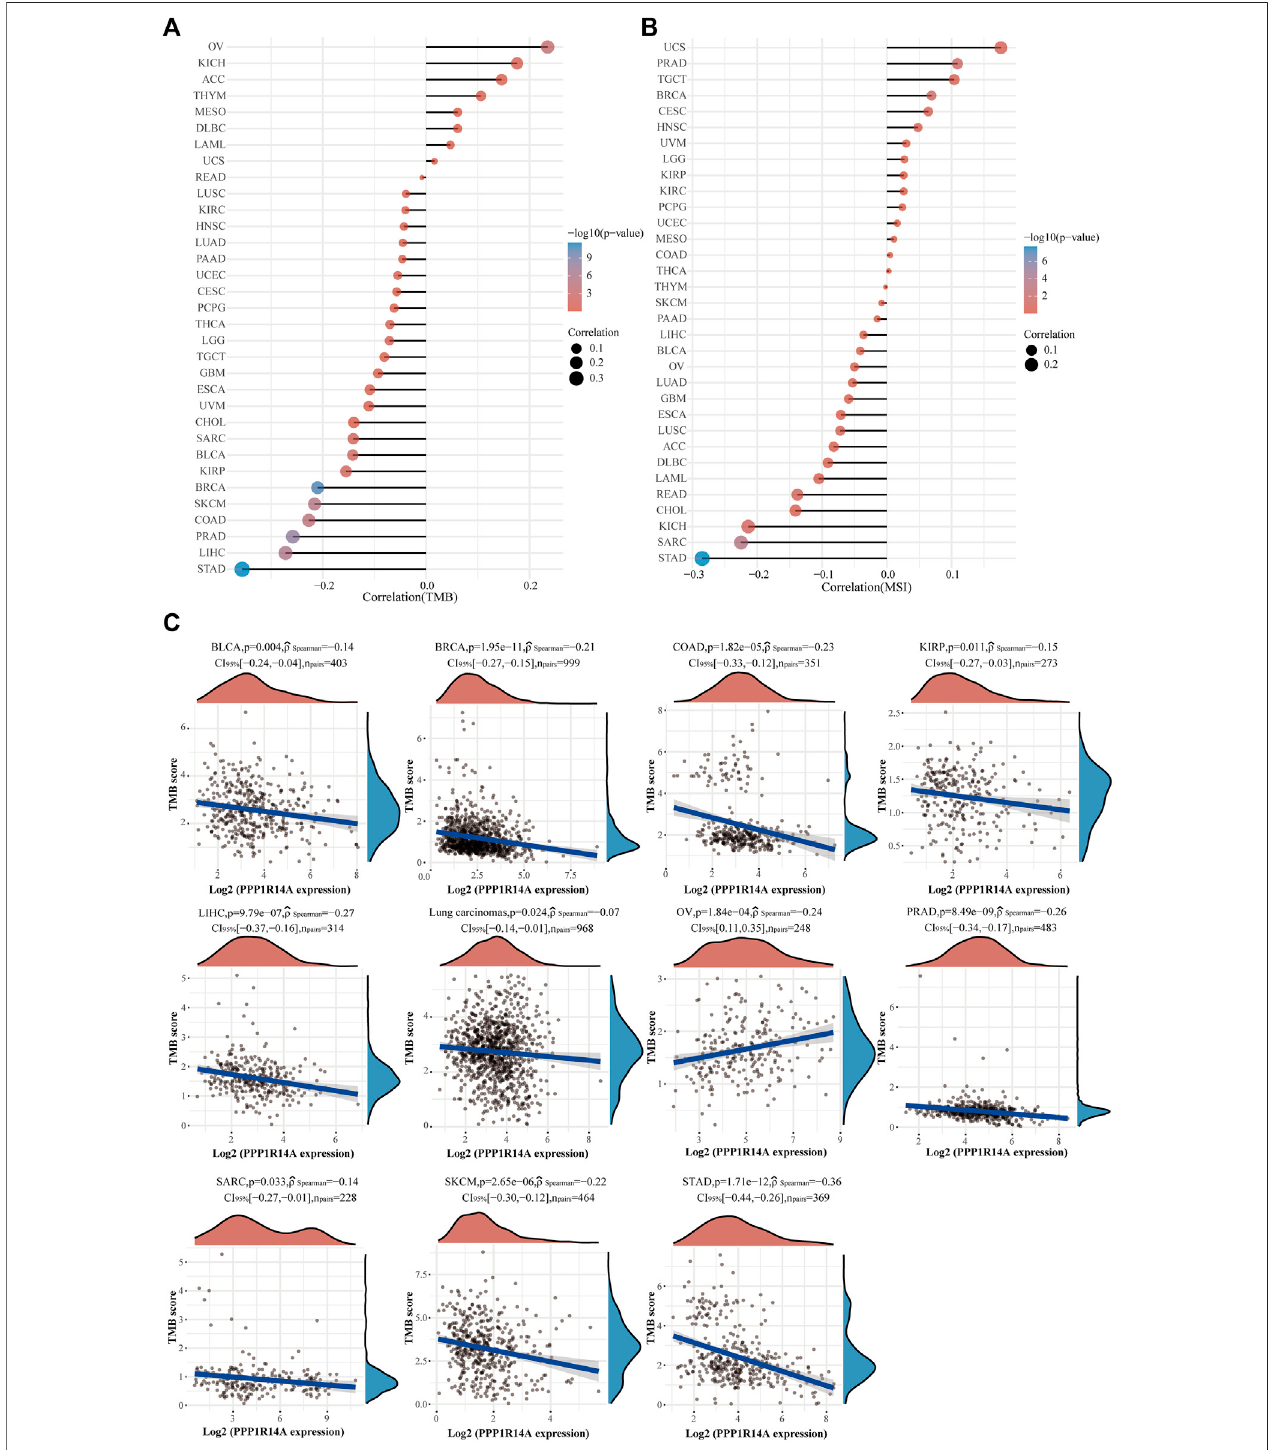
FIGURE13| Correlation between thePPP1R14A geneexpression and TMB and MSIin pan-cancer.Astick chartshowsthe relationshipbetweenthe PPP1R14A gene expression and TMB in diverse tumors. The red curve represents the correlation coef fi cient, and the blue value represents the range (A) . A stick chart shows the association between the PPP1R14A gene expression and MSI in diverse tumors (B) . Relationship between the PPP1R14A gene expression and TMB (C) or MSI (D) in pan-cancer.